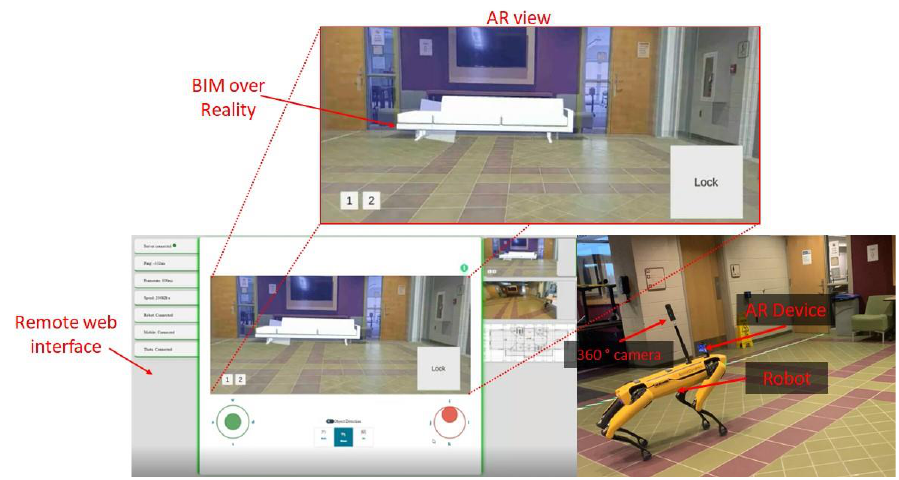
Figure 11. Experimental setup and user view in use case 1 experiment.